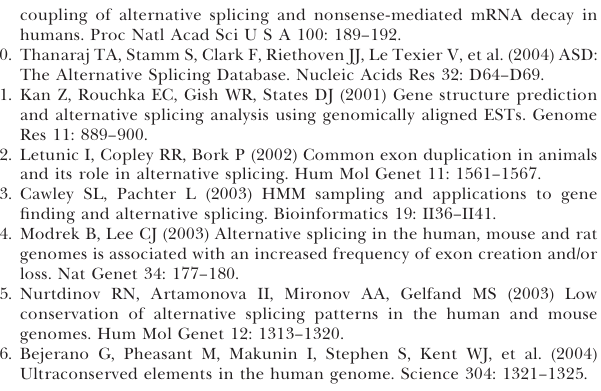
Figure S1. Expression of Newly Detected Skipped Exons in Different Human and Mouse Tissues (A) Expression of the newly validated exons in human liver tissue and a HeLa cell line. The sample numbering (i–vii) corresponds to the numbers in Figure 2A; the samples, except for sample v, show expression in brain tissue cDNA. Compared with Figure2A, it can be seen that the inclusion of the skipped exon is tissue specific rather than ubiquitous. Since the PCR product of sample v in Figure 2A was carried out on HeLa cell line cDNA, the reaction shown here (denoted with an asterisk) was carried out on brain tissue cDNA. (B) PCR results of newly detected isoforms in other human and in mouse tissues (see Figure 2) and validation of the orthologous mouse exons. Roughly half of these were additionally verified by sequencing of the mouse PCR products. Protocol S1. Detailed Information on Application and Results of the Ka/Ks Test Found at DOI: 10.1371/journal.pcbi.0010015.sd003 (29 KB